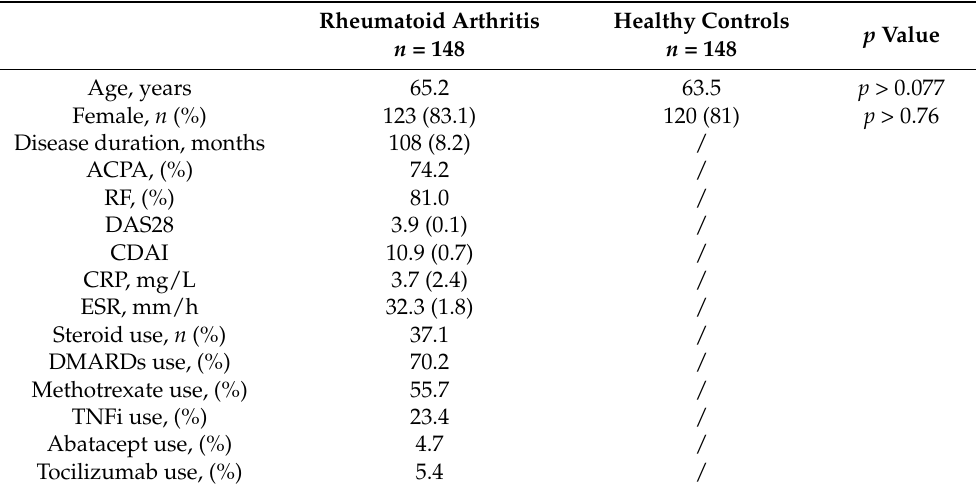
Table 1. Demographic and clinical characteristics of patients and healthy controls